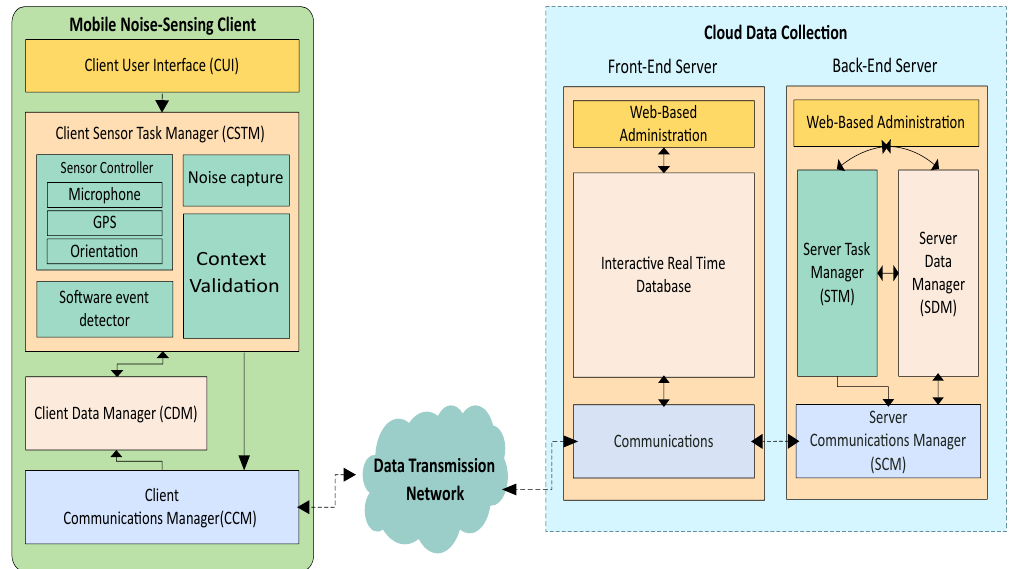
Figure 2. Proposed crowdsensing architecture for mobile noise